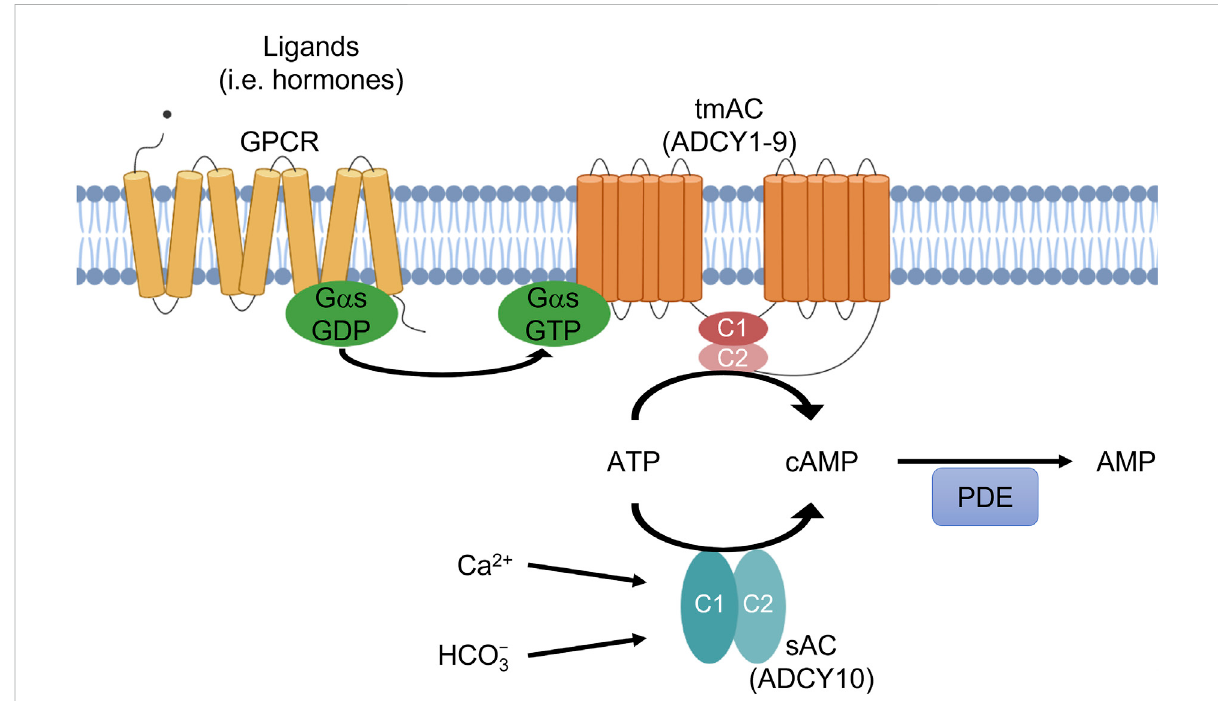
FIGURE 1 Two sources of cAMP in mammalian cells. ADCY1-9 are transmembraneadenylyl cyclases (tmACs) regulatedby G-proteins. ADCY10 is soluble adenylyl cyclase (sAC) regulated byHCO 3 − and Ca 2+ ions. Phosphodiesterases(PDEs) degrade cAMP. sAC and tmACs both produce cAMP which has distinct